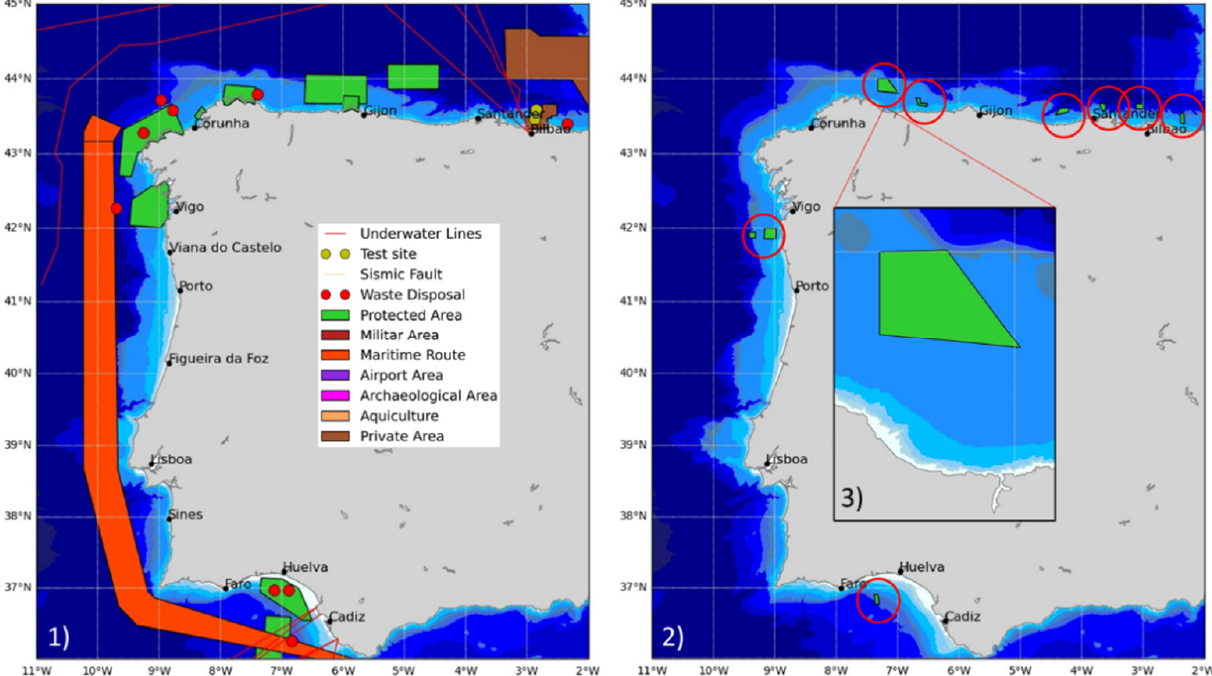
Figure 2. Floating wind map in Spain. (1) Some restrictions present in Spanish waters. (2) Floating wind farm proposed. (3) Ribadeo floating wind farm.